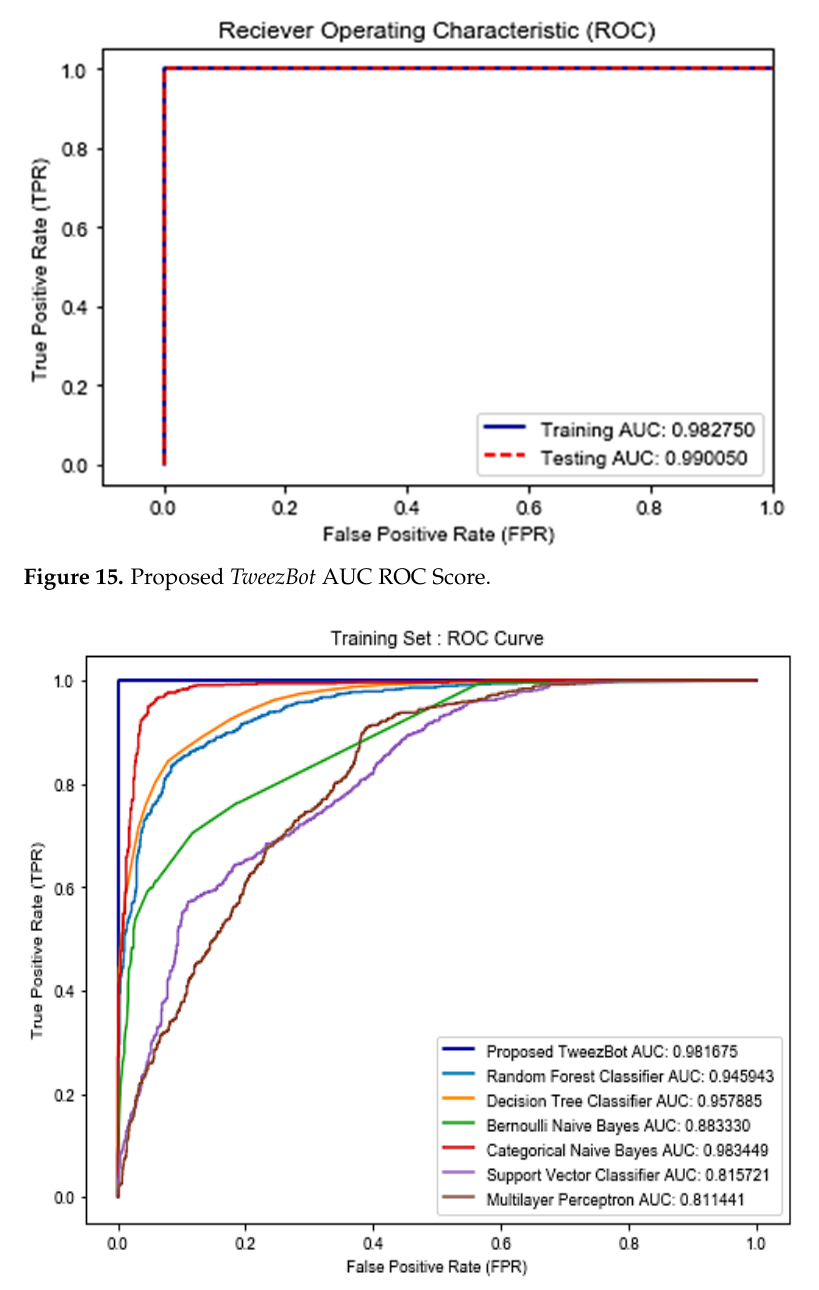
Figure 17. Comparative Analysis of Accuracy for Various Classifiers while Testing . The following Table 3 shows the comparative analysis of the TweezBot against two tree-based algorithms, two Naïve Bayes models, an SVM classifier, and a multi-level per- ceptron. Hence, the testing and training scores are exhaustively summarized for different types of machine leaning and deep learning models. Random forest, being an ensemble model, can be seen providing better results than decision tree. Additionally, the categori- cal version is considered suitable for performing the prediction of a target variable that is categorically distributed. However, our TweezBot has outperformed all its existing coun- terparts in terms of accuracy and AUROC scores while training and testing.